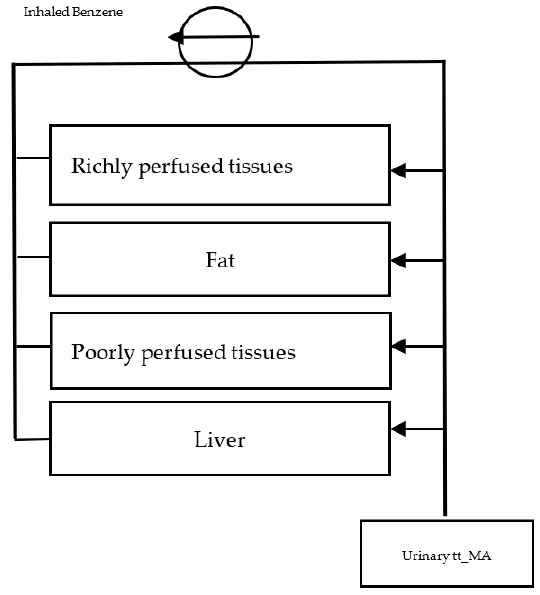
Figure 2. Reverse-translation PBPK model.